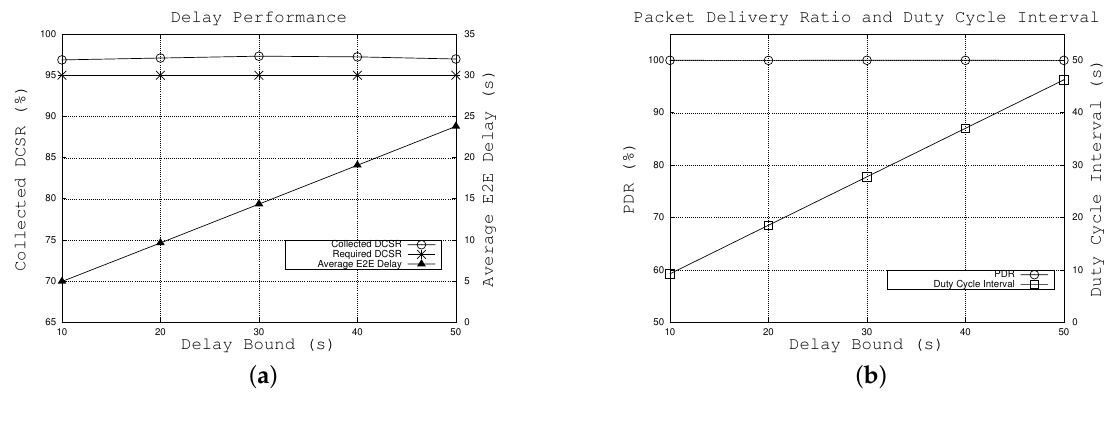
Figure 5. Effects of the delay bound. ( a ) effects on achieved DCSR and average E2E delay, ( b ) effects on packet delivery ratio and duty cycle